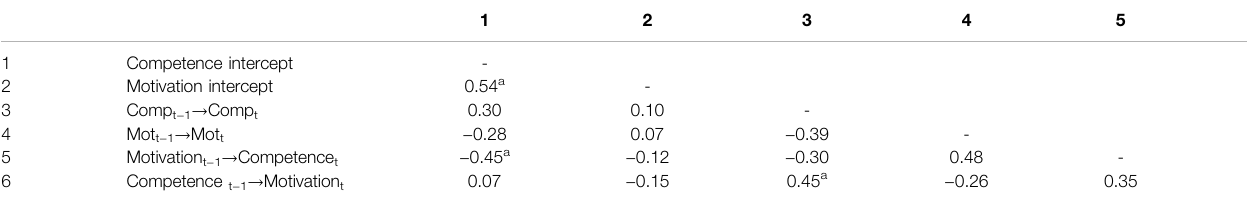
TABLE 6 | Standardized between-person correlations for the random effects from the bivariate autoregressive